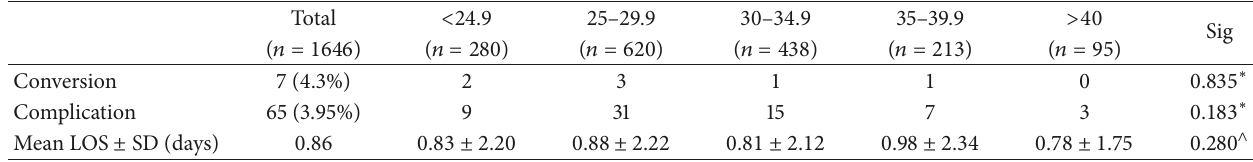
Table 4: Table showing patient outcomes categorized by BMI group.